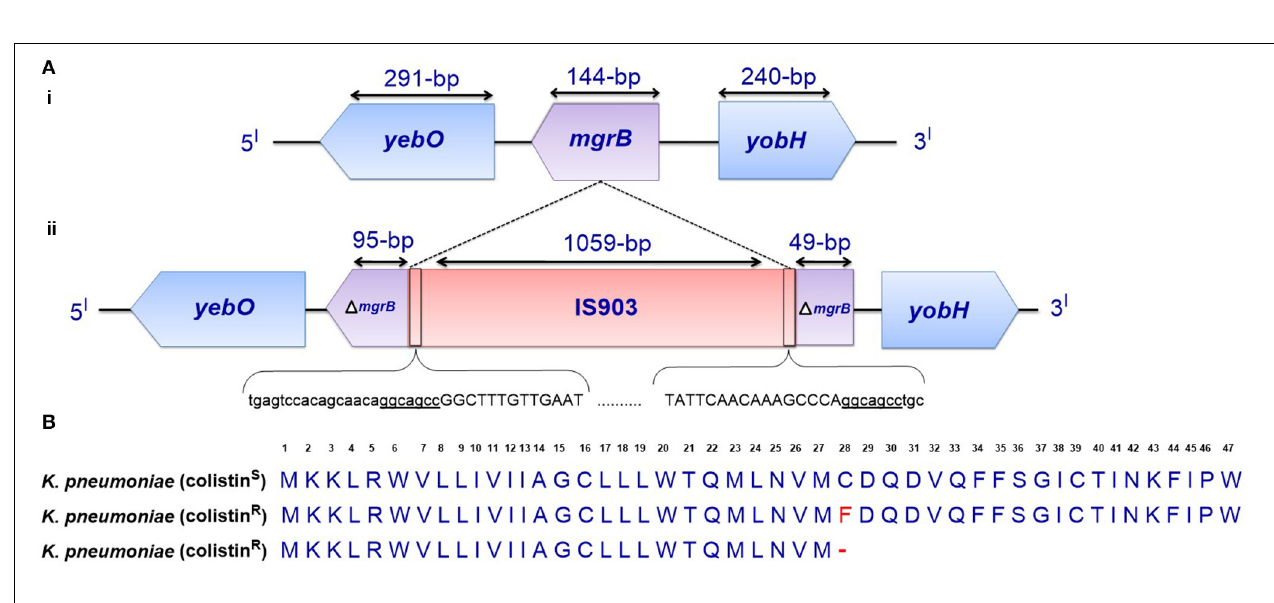
FIGURE 3 | (A) Genetic representation of the phoP/phoQ negative regulator, mgrB . (i) K. pneumoniae with intact mgrB (colistin-susceptible), and (ii) K. pneumoniae with mgrB truncated by an insertion sequence (colistin-resistant). (B) Alignment of